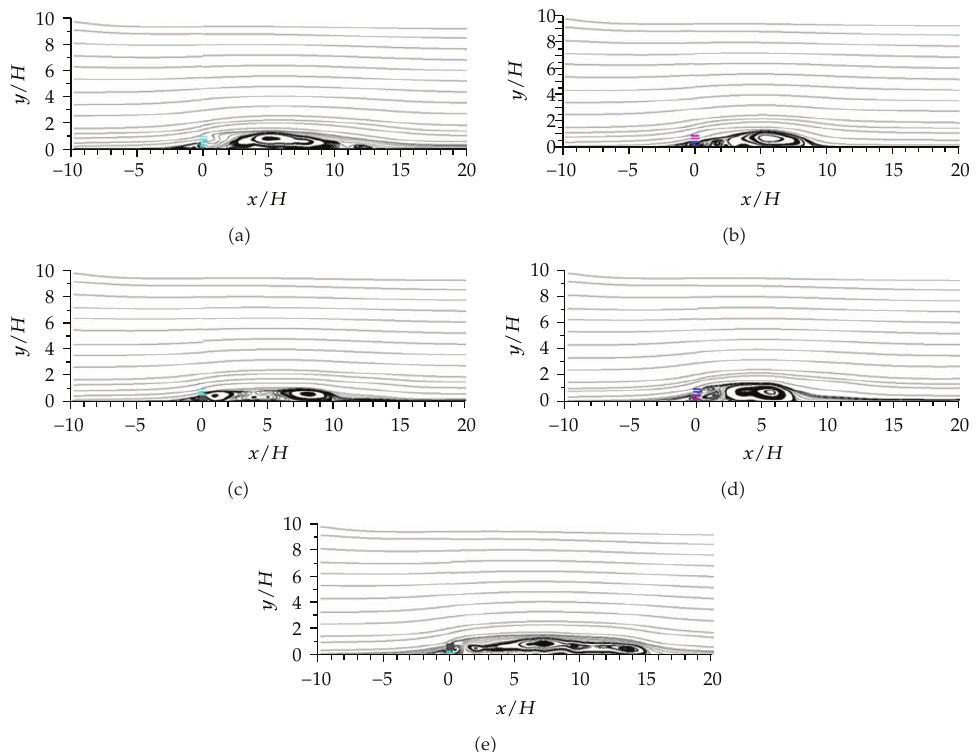
Figure 7: Comparison between calculated streamline patterns around various porous